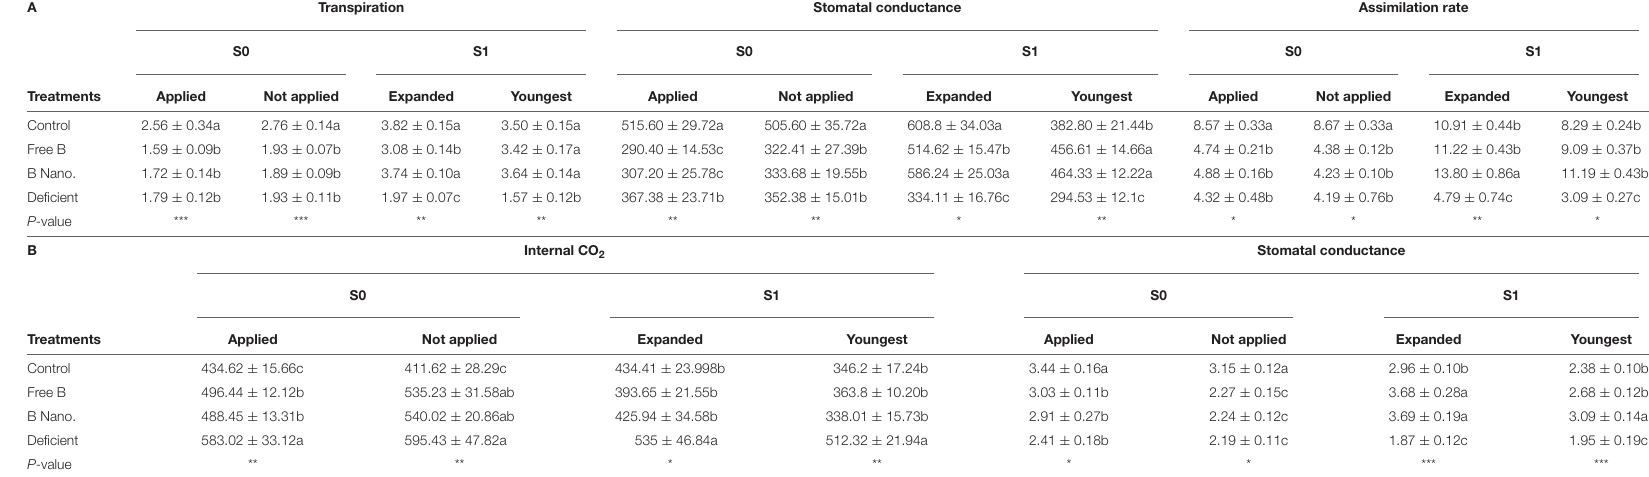
Levels of significance are represented by * p < 0.05; ** p < 0.01; and *** p < 0.001. Different letters indicate significant differences among treatments according to Duncan’s test (p < 0.05). Values are means ± SE (n = 8). Two independent experiments have been carried